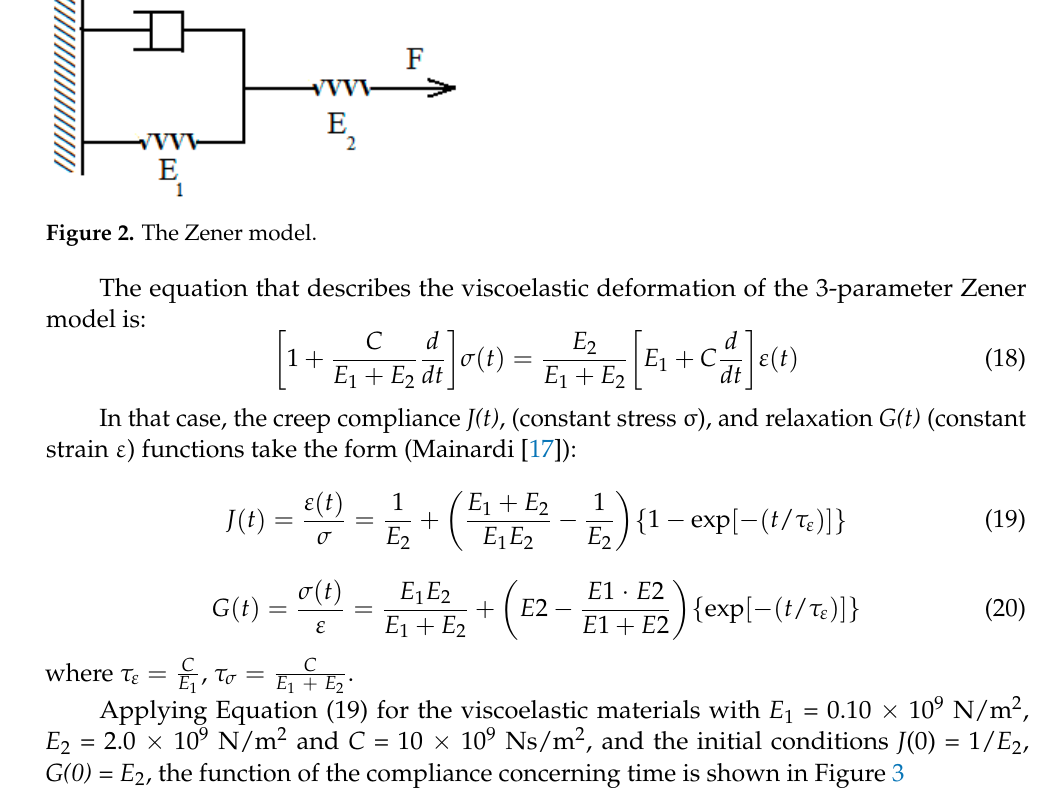
Figure 2. The Zener model.